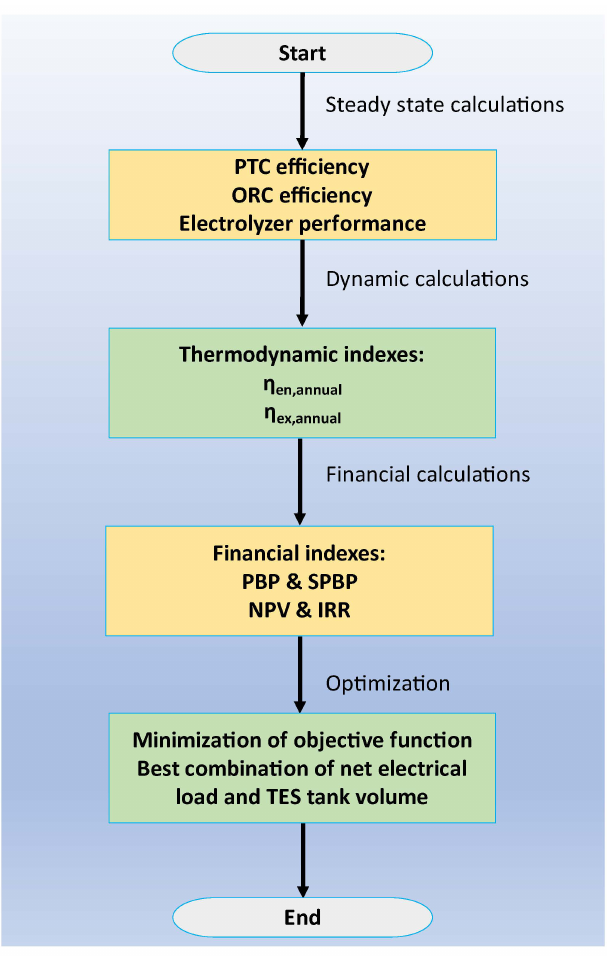
Figure 2. Flow chart of the solution